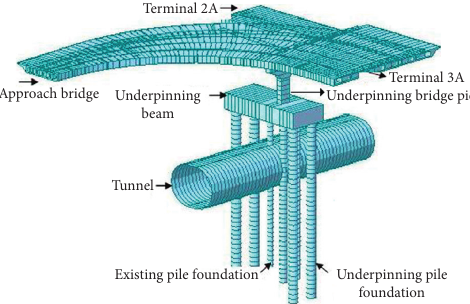
Figure 1: Diagram of underpinning